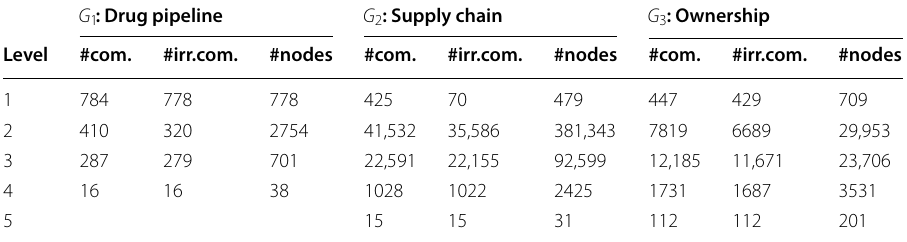
Table 7 Statistics for the communities detected by using the multi-coding Infomap